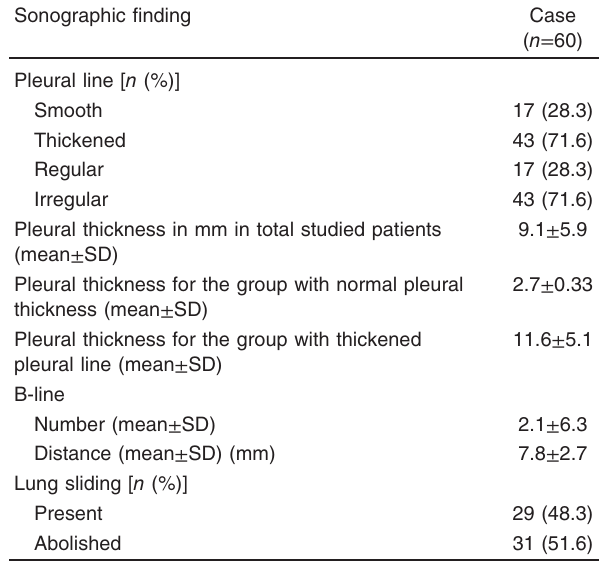
Table 4 Thoracic ultrasound parameters in total studied